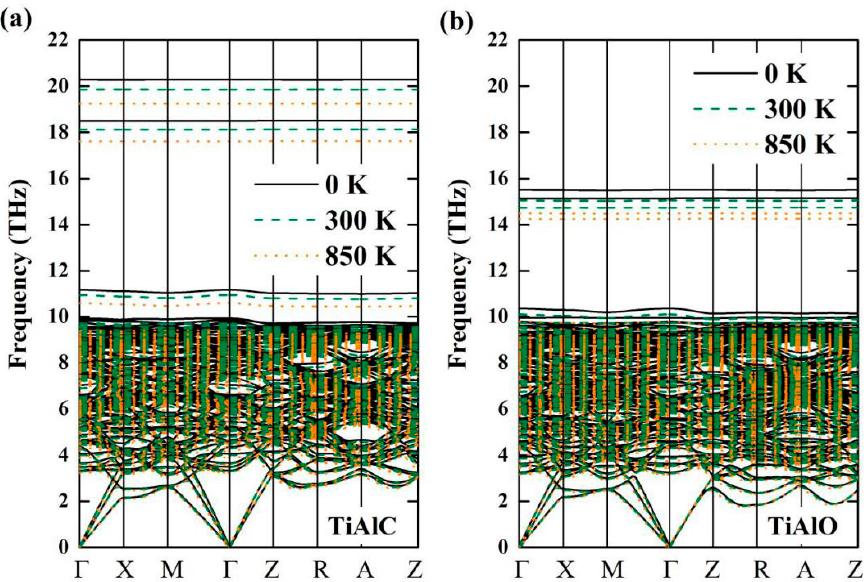
Figure 5. Phonon dispersion relations of TiAlC ( a ) and TiAlO ( b ) along high-symmetry q points in Brillouin zone at 0 K, 300 K, and 850 K, respectively.